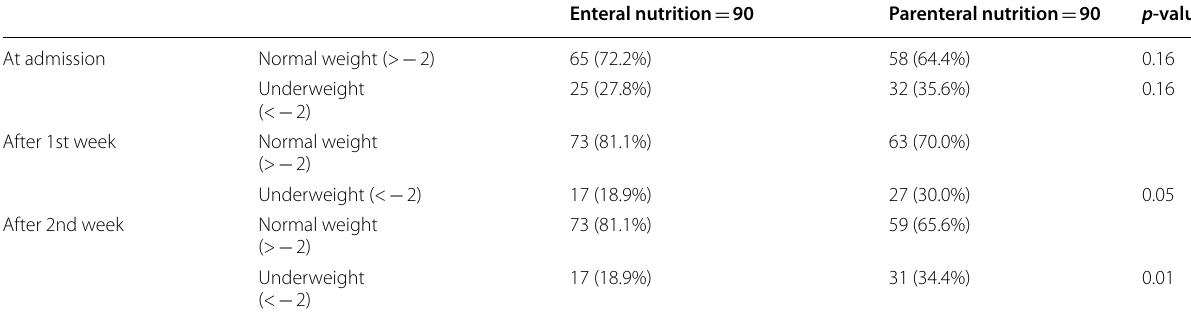
Z-score grade at different times is represented as frequency and percent, the data were analyzed by Χ 2 test (2 and lt; 2 for weight for age mean −